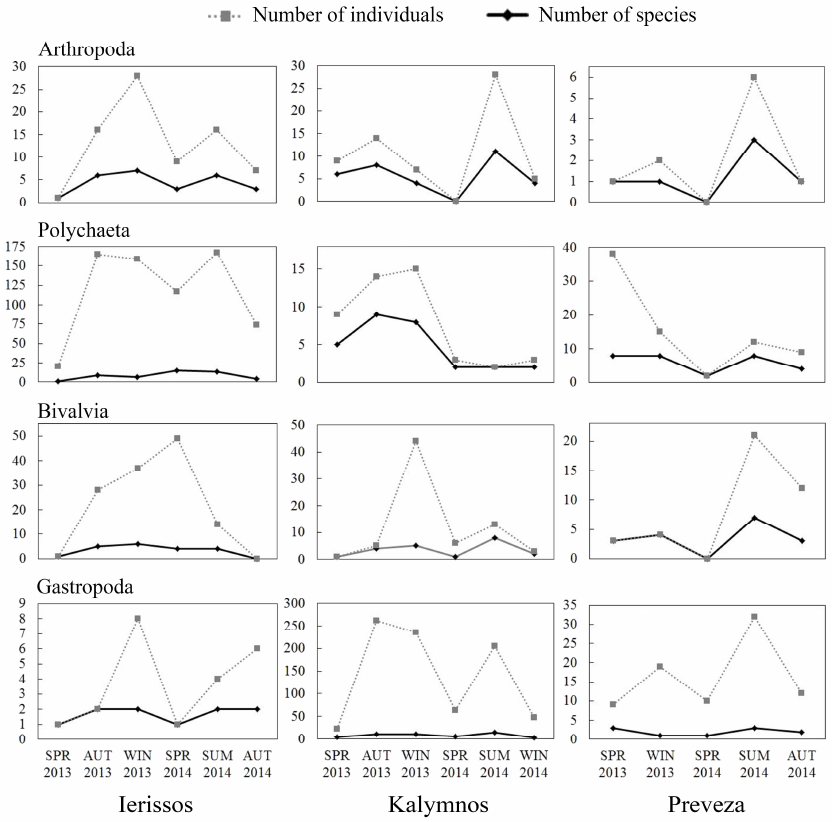
Figure 5. Number of species and individuals of the dominant taxa for the three artificial reefs, seasonally. Spring: SPR; Summer: SUM; Autumn: AUT; Winter: WIN.